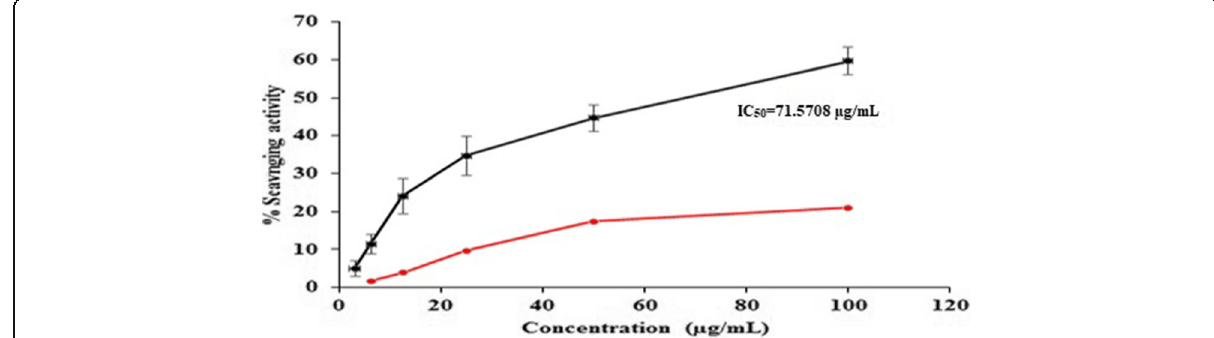
Fig. 2 Comparison of DPPH radical scavenging activity of poly herbal formulations. PHF1 (black) and PHF2